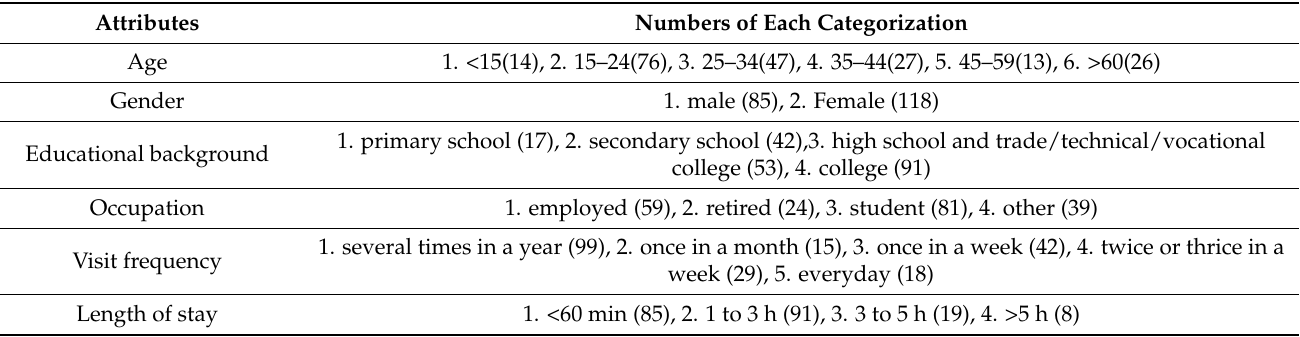
Table 2. The personal characteristics of the